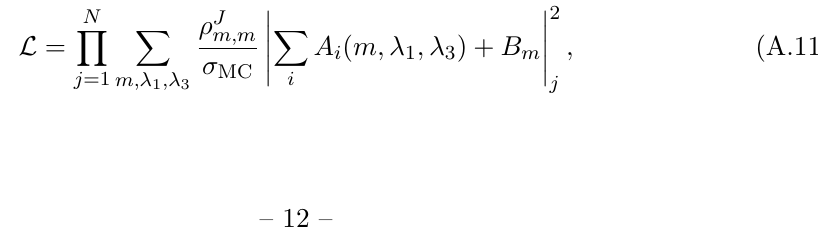
final states from the χ rest frame, x – y – z to the three-body helicity system, X – Y – Z by cJ three Euler angles, α, β ,and γ as shown in figure 8. The calculations of Euler angles can be found in